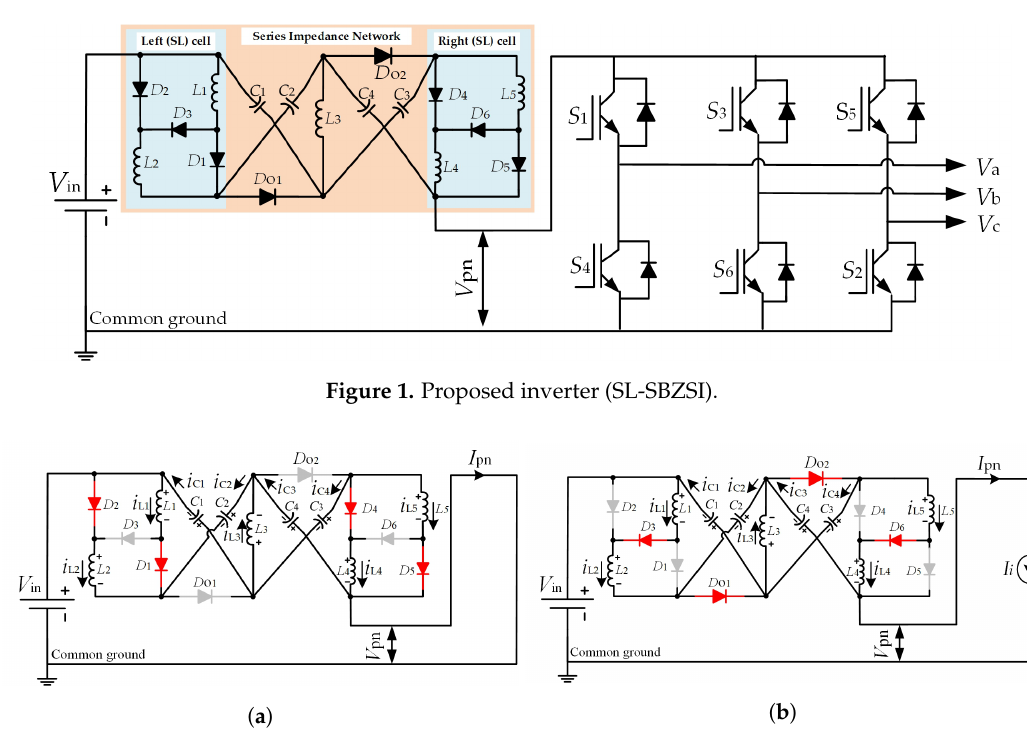
Figure 2. Equivalent circuit: ( a ) shoot-through mode ( b ) non-shoot-through